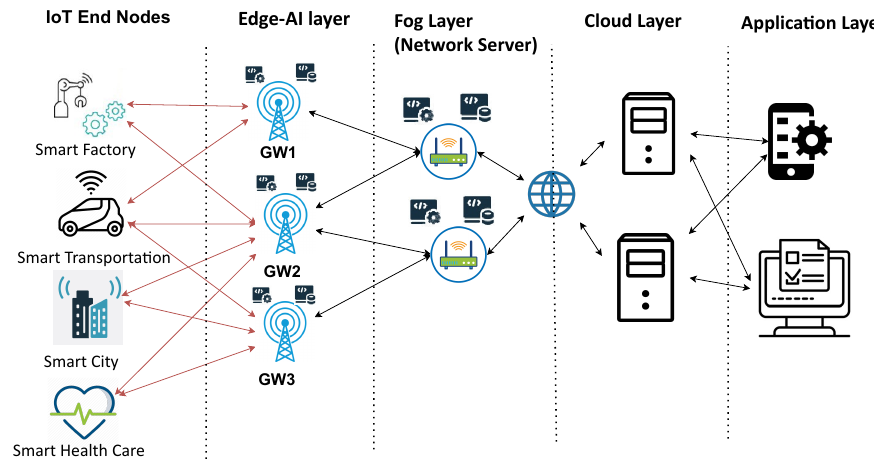
Figure 3. Fog and Edge-AI-based